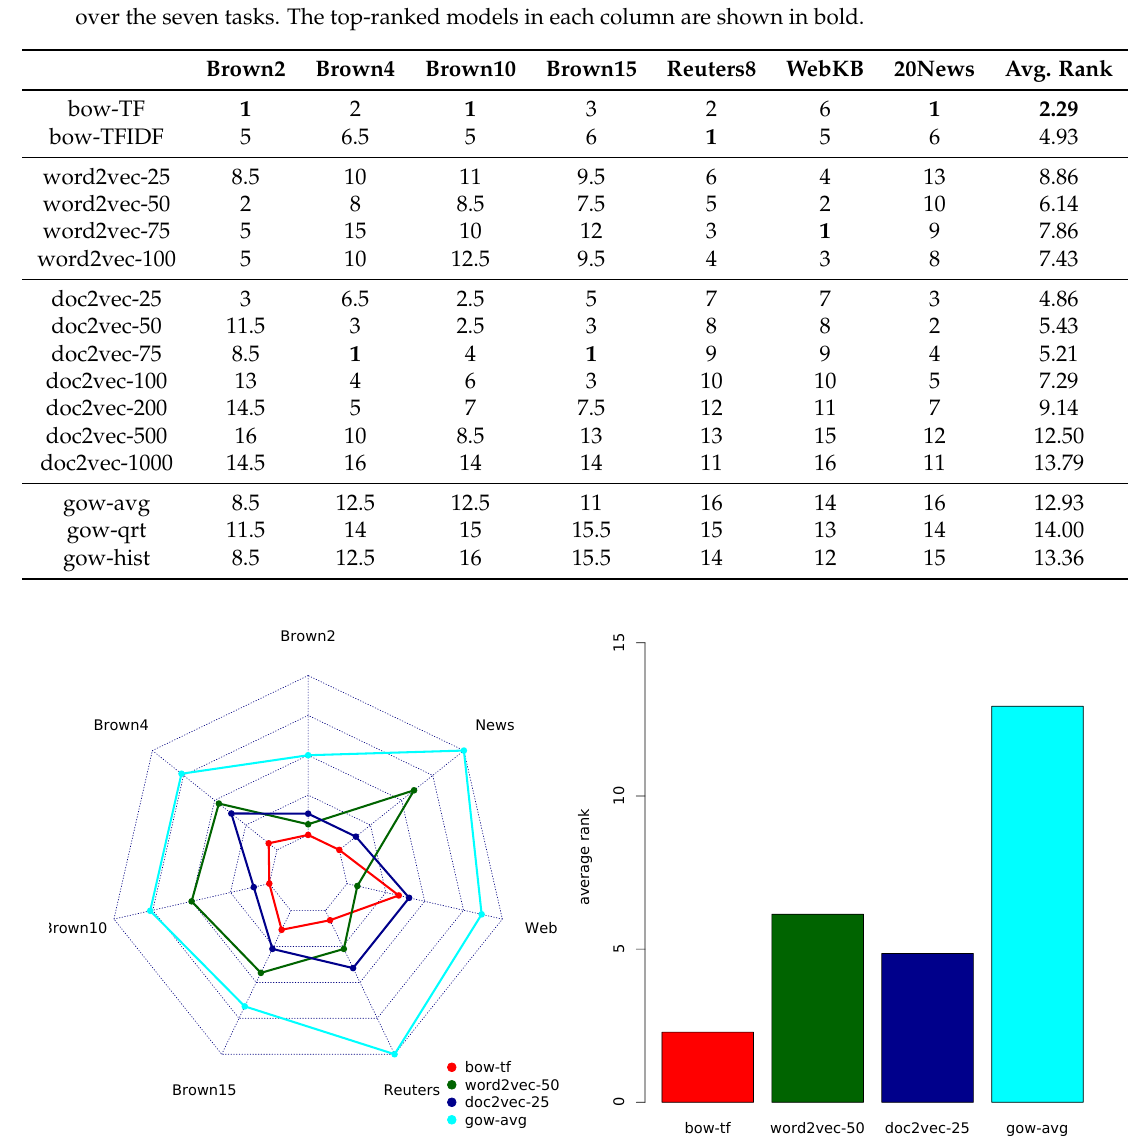
Figure 4. Radar-chart comparison of the rankings by task ( left ) and their averages ( right ) for the four top-performing variants of the document representation models in each of the four groups with respect to classification